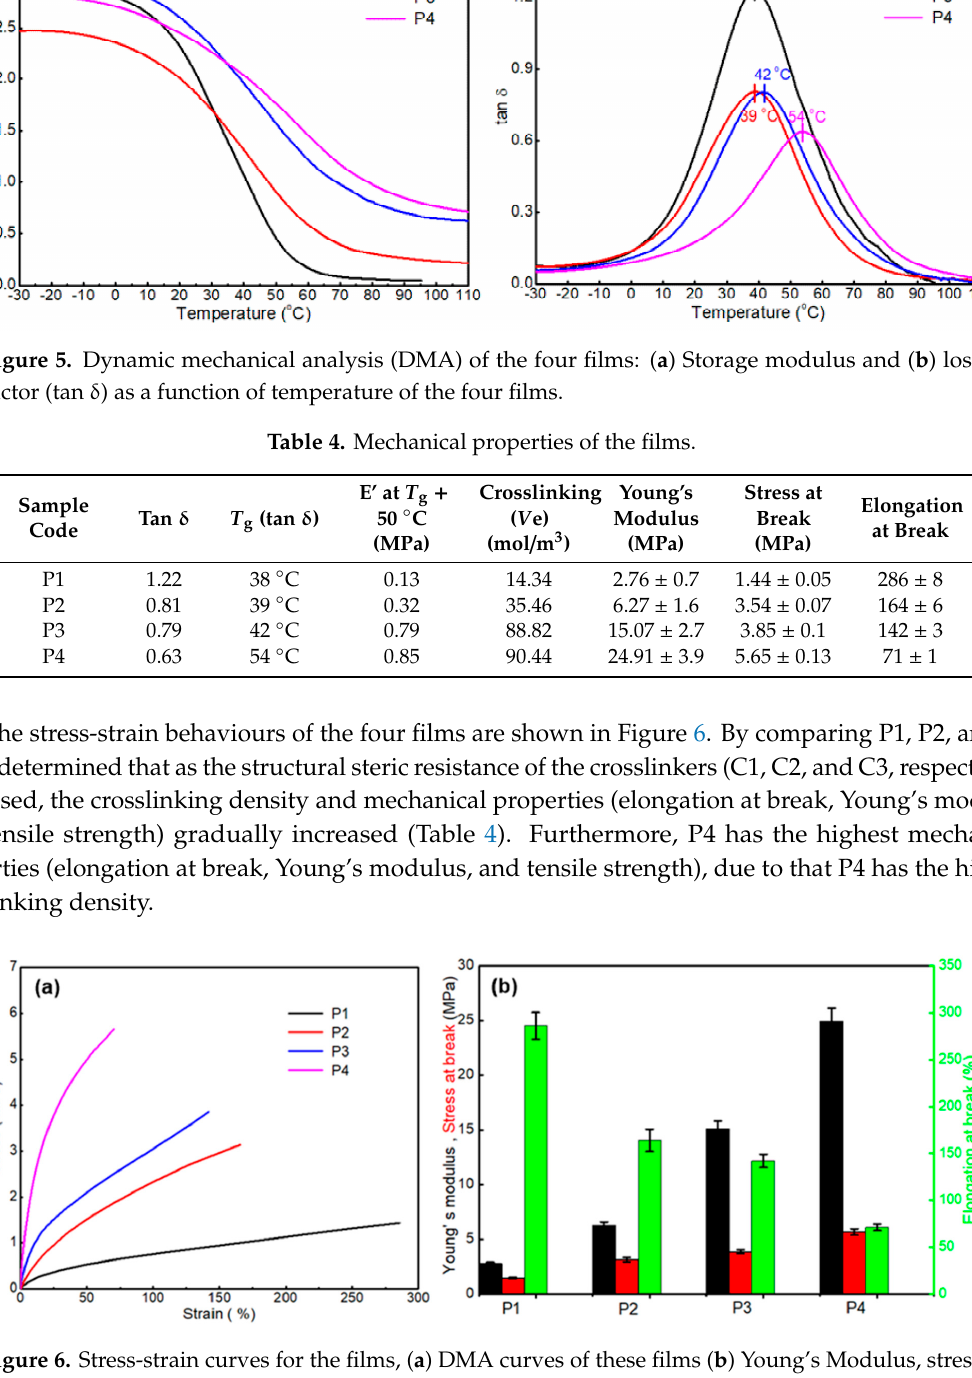
Figure 6. Stress-strain curves for the films, ( a ) DMA curves of these films ( b ) Young’s Modulus, stress Figure 5. Stress-strain curves for the films, (a) DMA curves of these films (b) Young's Modulus, stress at Break, and tensile strength of these cured at Break, and tensile strength of these cured samples.